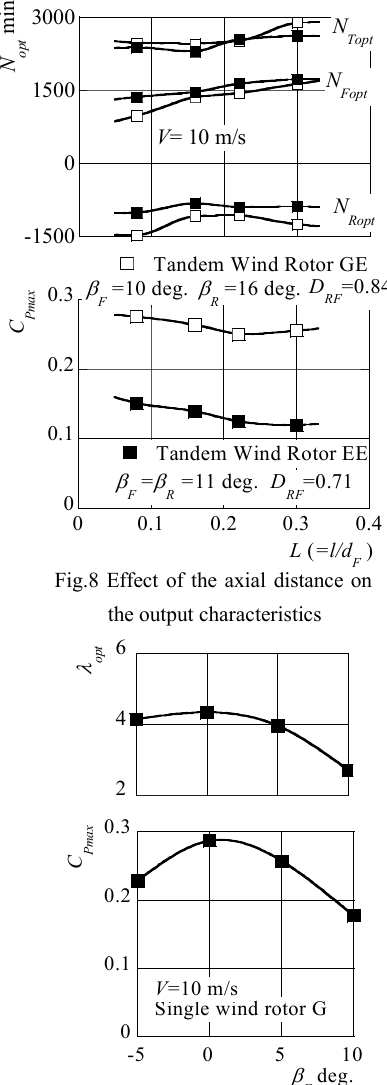
Fig.9 Output of the single wind